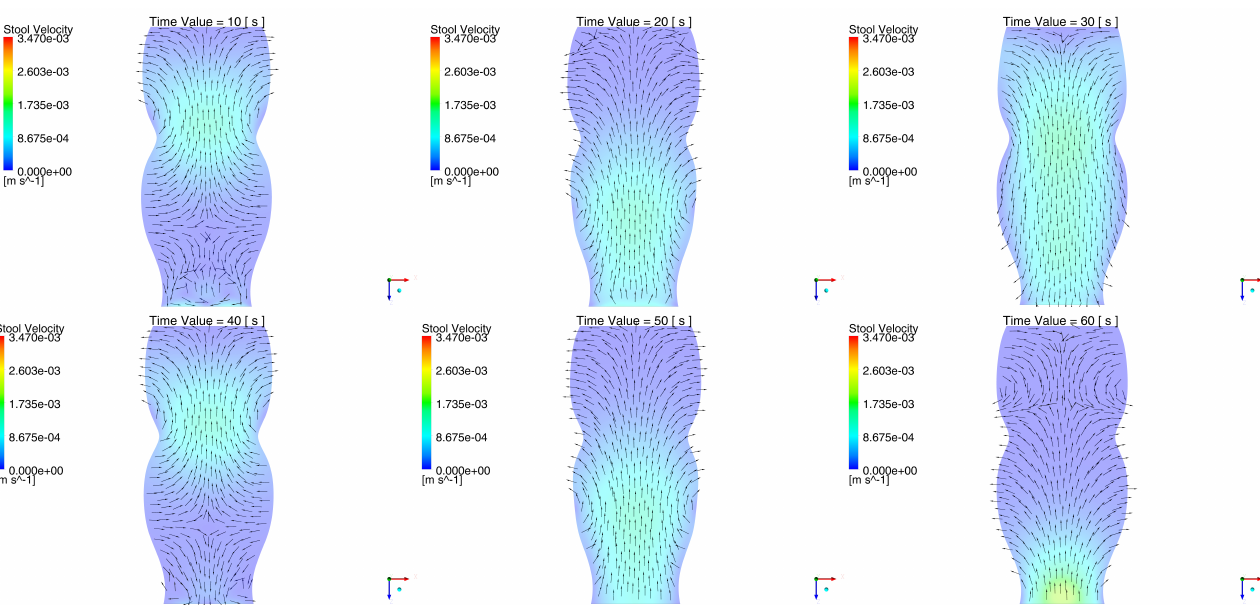
Figure 3. Stool velocity during the type II waves between 10 s and 60 s. The fecal velocity field can be seen in the anterograde and retrograde directions, which implies consistency with the physical behavior described by the fecal mass after the passage of a peristaltic wave.